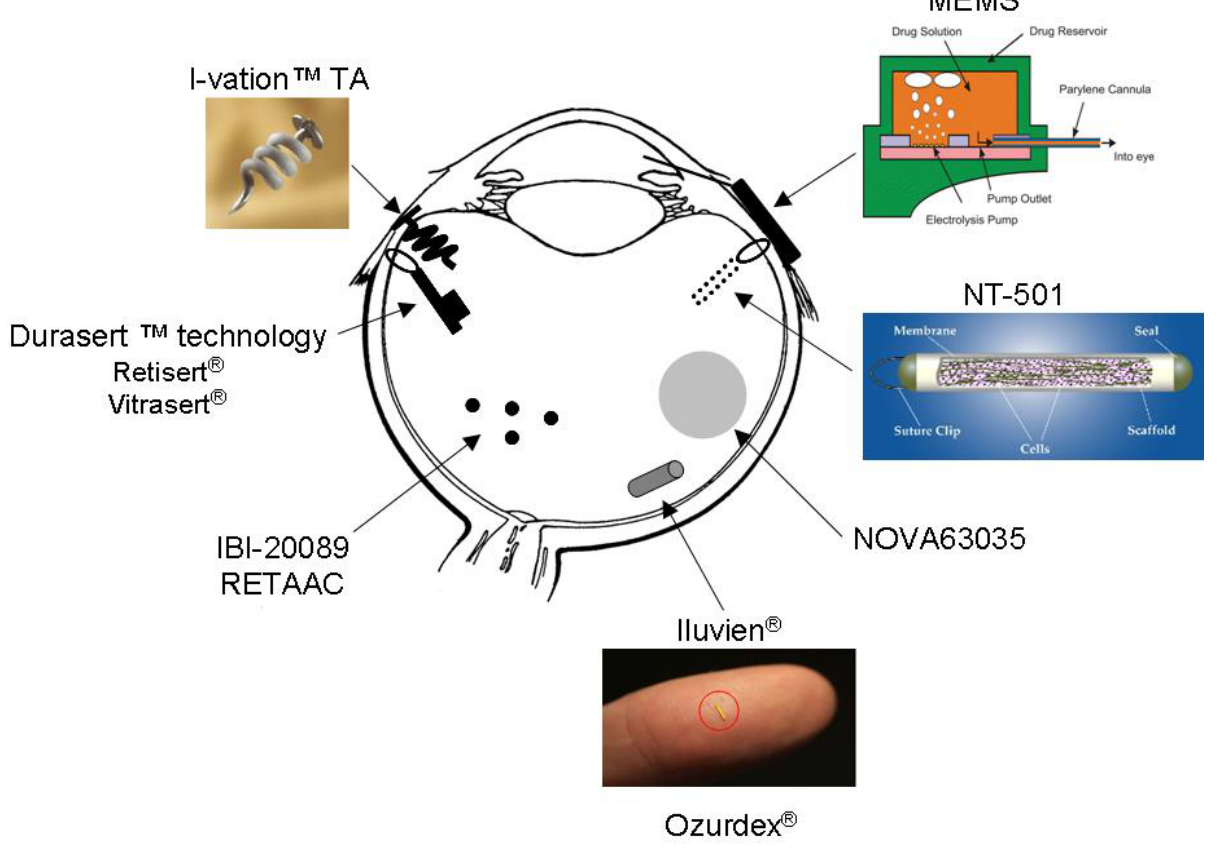
Figure 2. Example of intravitreal drug delivery systems for vitreoretinal diseases. Adapted from Kuno, N.; Fujii, S. Biodegradable intraocular therapies for retinal disorders.